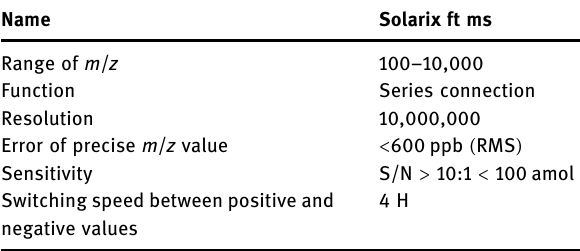
Table 1: Parameters of the mass